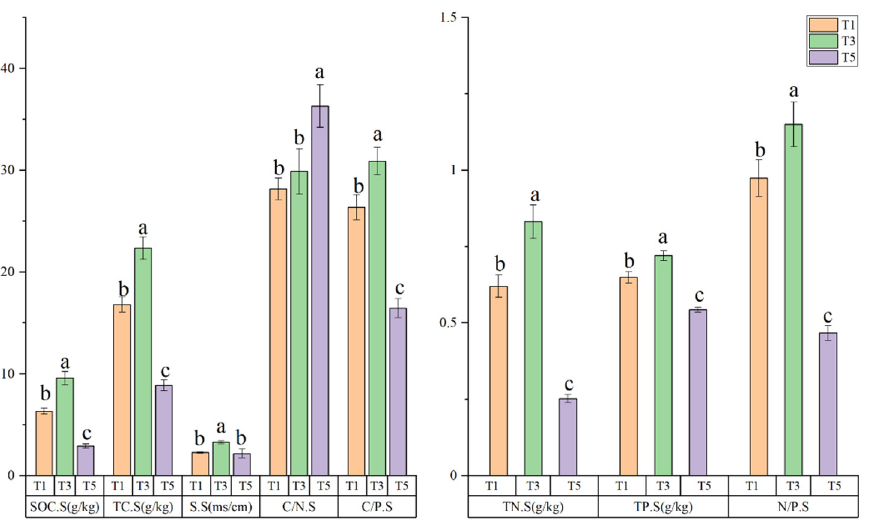
Figure 3. Soil eco-stoichiometry, organic carbon (C), and salinity characteristics at different tidal levels: 1, 3, and 5 km from the coastline (T1, T3, and T5, respectively). Lowercase letters represent differences at p < 0.05. SOC.S: soil organic C content; TC.S: total soil C content; TN.S: soil total nitrogen (N) content; TP.S: soil total phosphorus (P) content; S.S: soil salinity; C/N.S: soil C/N ratio, C means TC.S; C/P.S: soil C/P ratio, C means TC.S; N/P.S: soil N/P ratio.